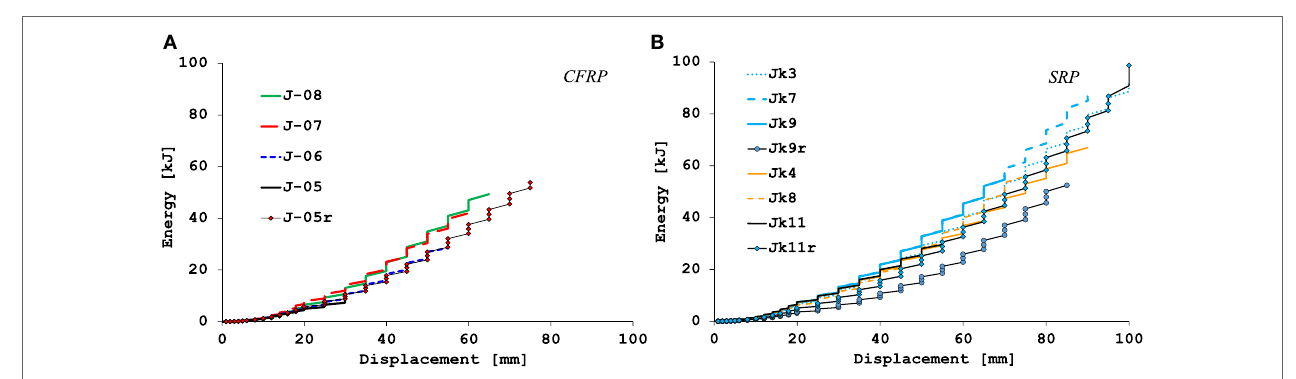
Frontiers in Materials |